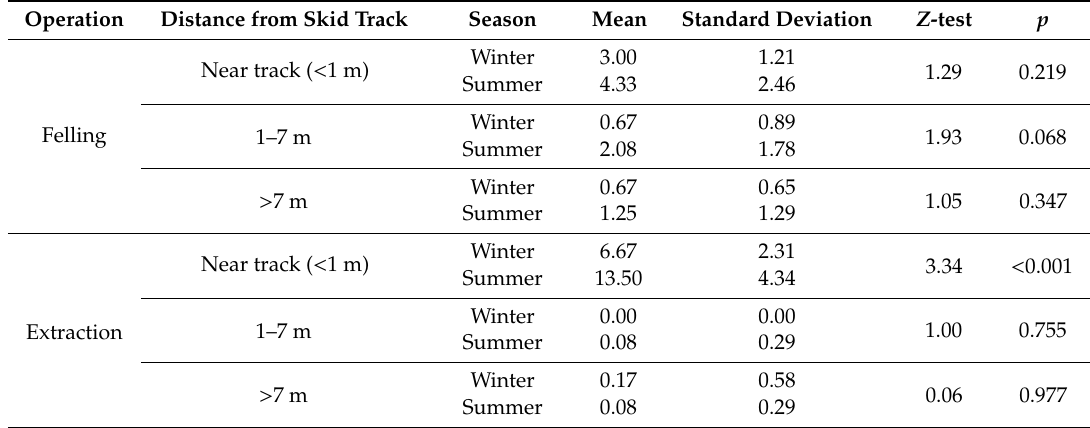
Table 4. Number of damaged trees with respect to distance from skid